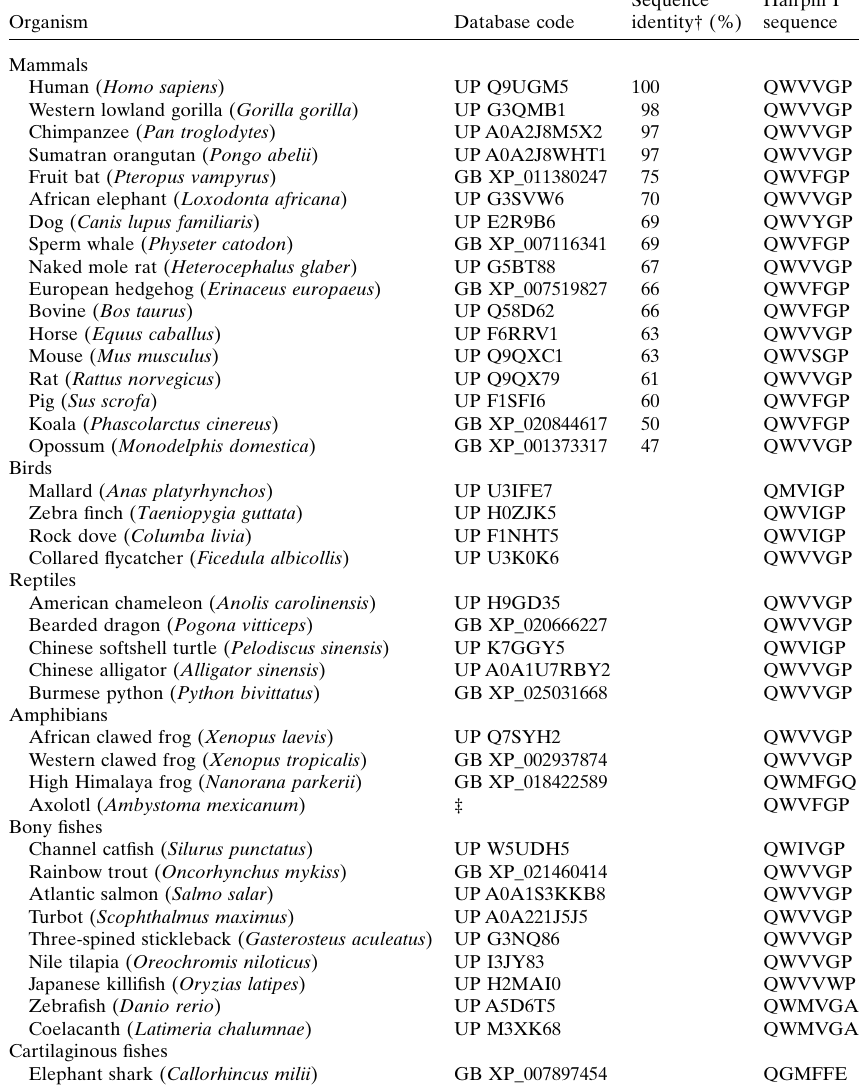
Table 3 Potential fetuin-B orthologs in vertebrates. All sequences contain the intact CPDCP-trunk motif. UP, UniProt; GB, GenBank. Sequence identity with human fetuin-B was determined only for mammalian sequences, as they share the same overall protein length and architecture. Other vertebrate sequences share domains CY1 and CY2 but have highly variable